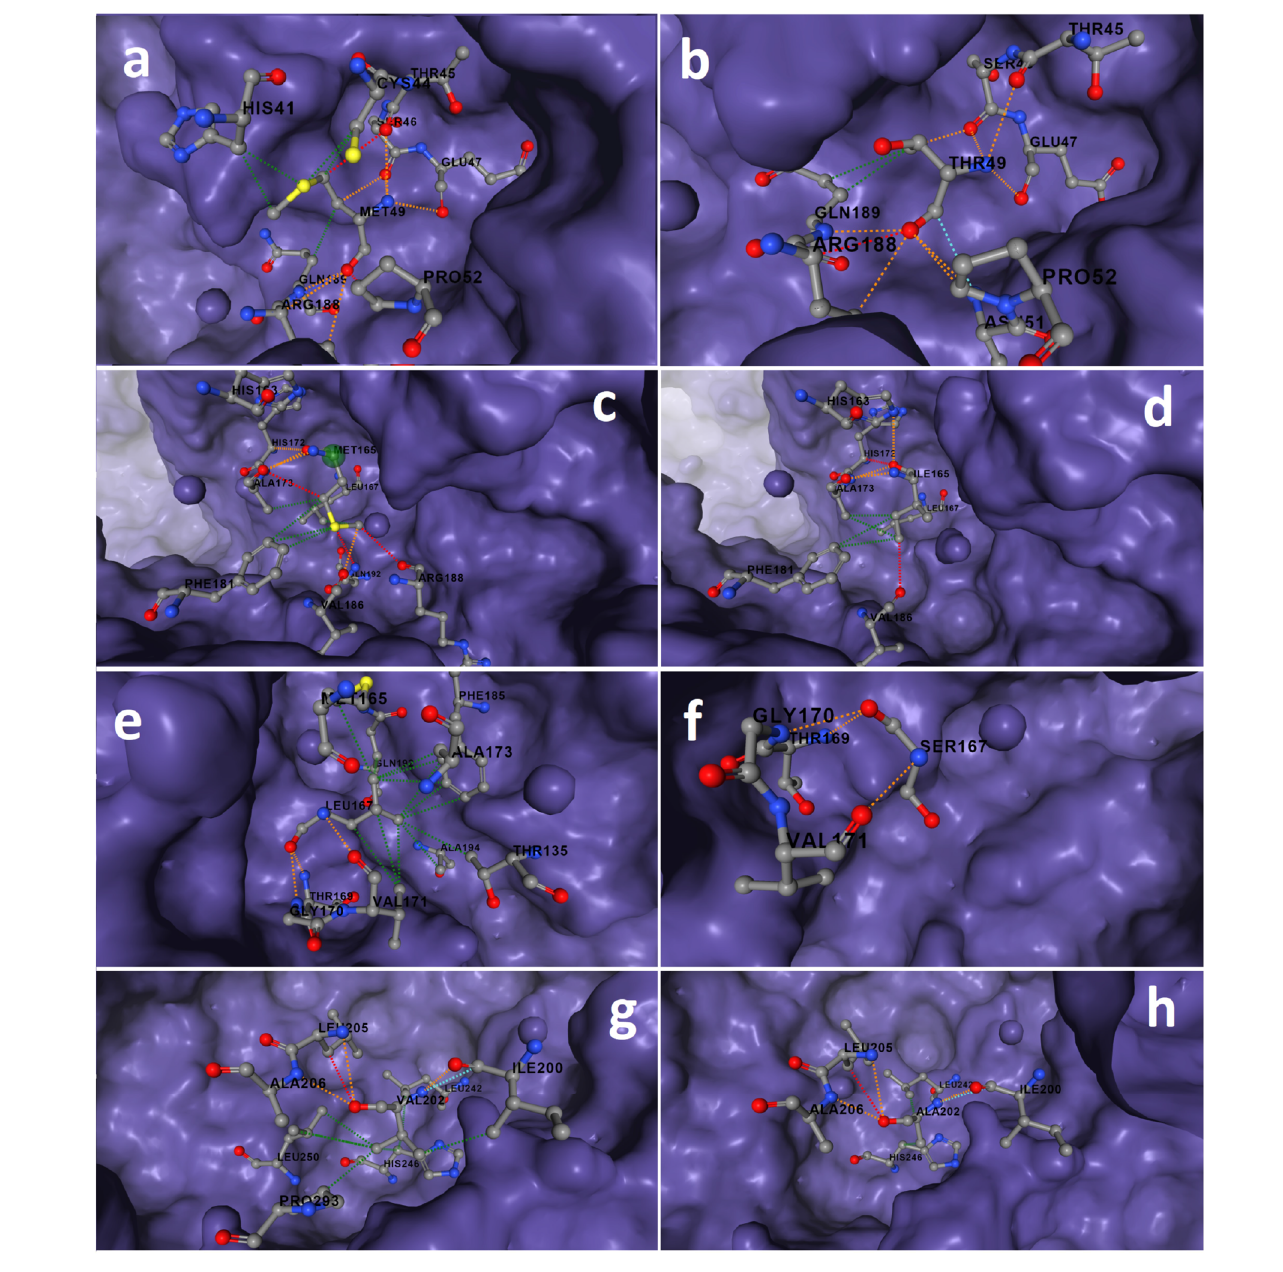
Figure 1 - Surface-stick illustration of changes in protein stability induced by highly destabilizing mutations of 3CL pro of SARS-CoV-2. a) Met49/ wild-type, b) Thr49/mutant, c) Met165/wild-type, d) Ile165/mutant, e) Leu167/ wild-type, f) Ser167/mutant, g) Val202/wild-type, h) Ala202/mutant. Bond legends; red-hydrogen, green-hydrophobic, orange-polar, blue-van der walls, navy